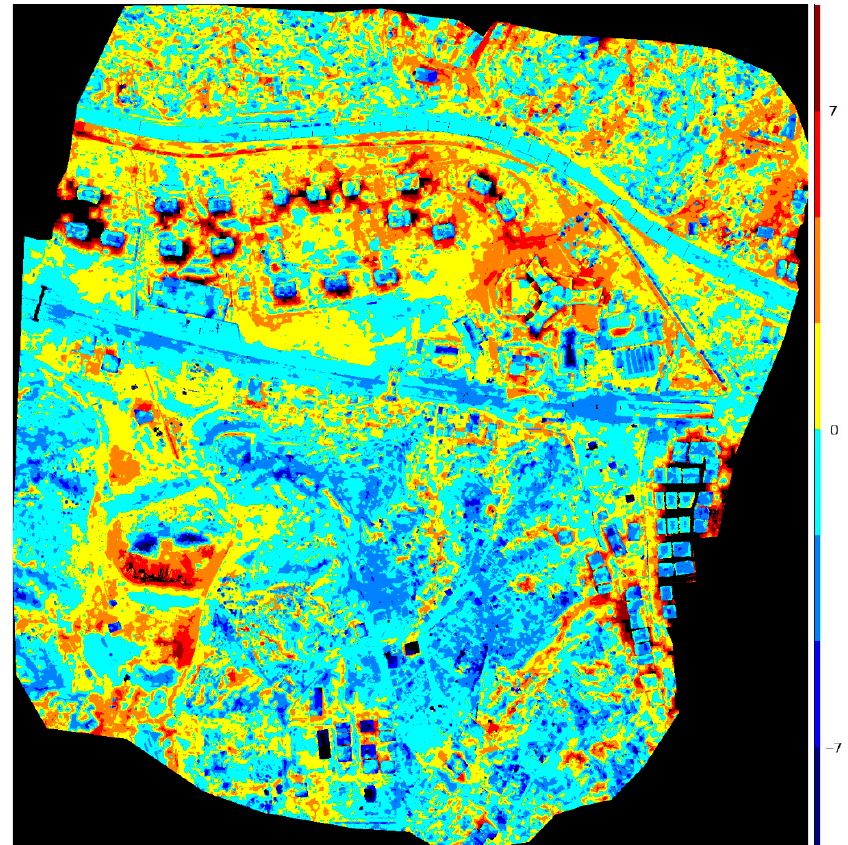
Figure 16. Discrepancy map between the SkySat and the UAV DSMs over the Ankara test site (in meters).